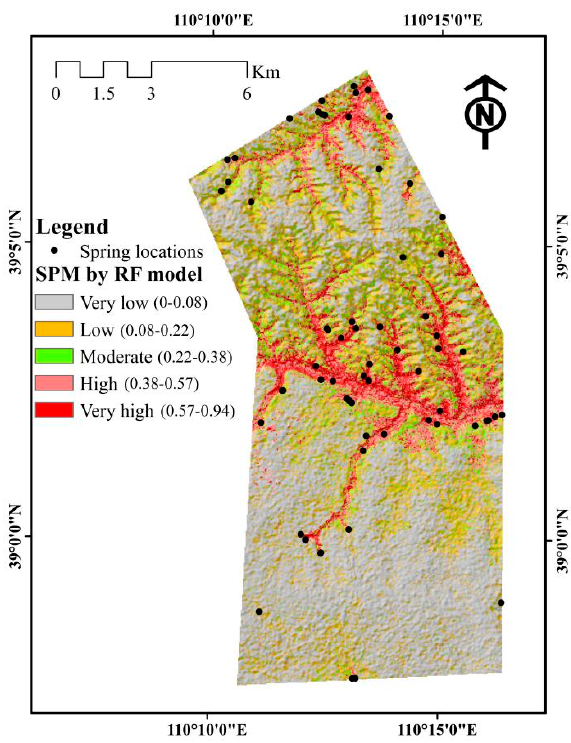
Figure 7. Groundwater spring potential map by the RF model.